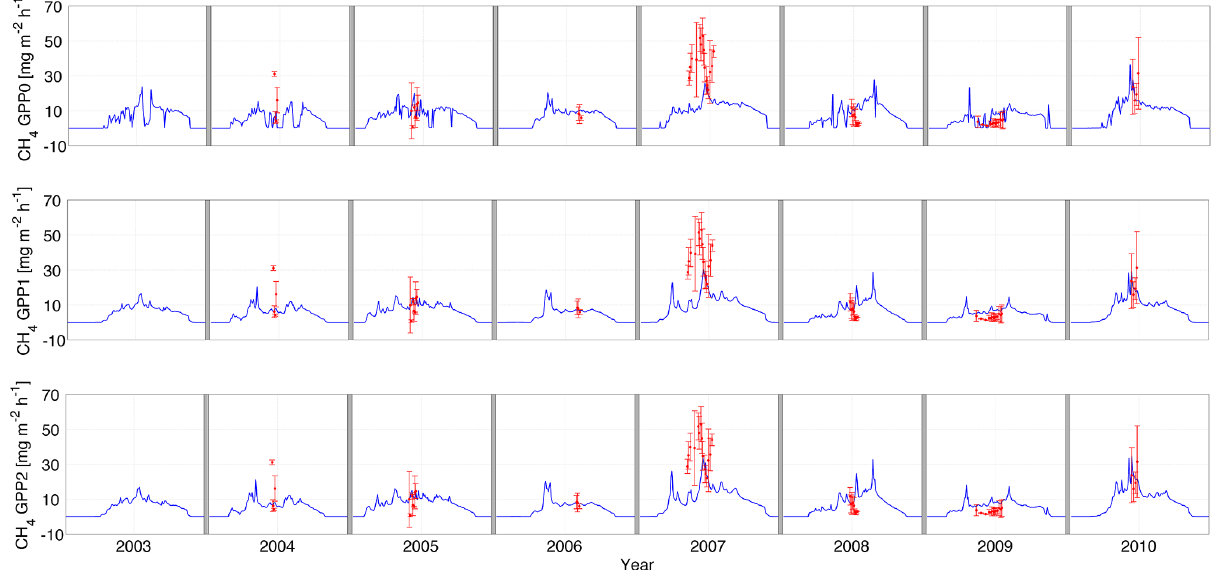
Figure 5. CH 4 flux produced by Peatland-VU compared with data, floodplain wet group (FW2), 2003 to 2010. For data (red), the standard error is shown by an error bar.